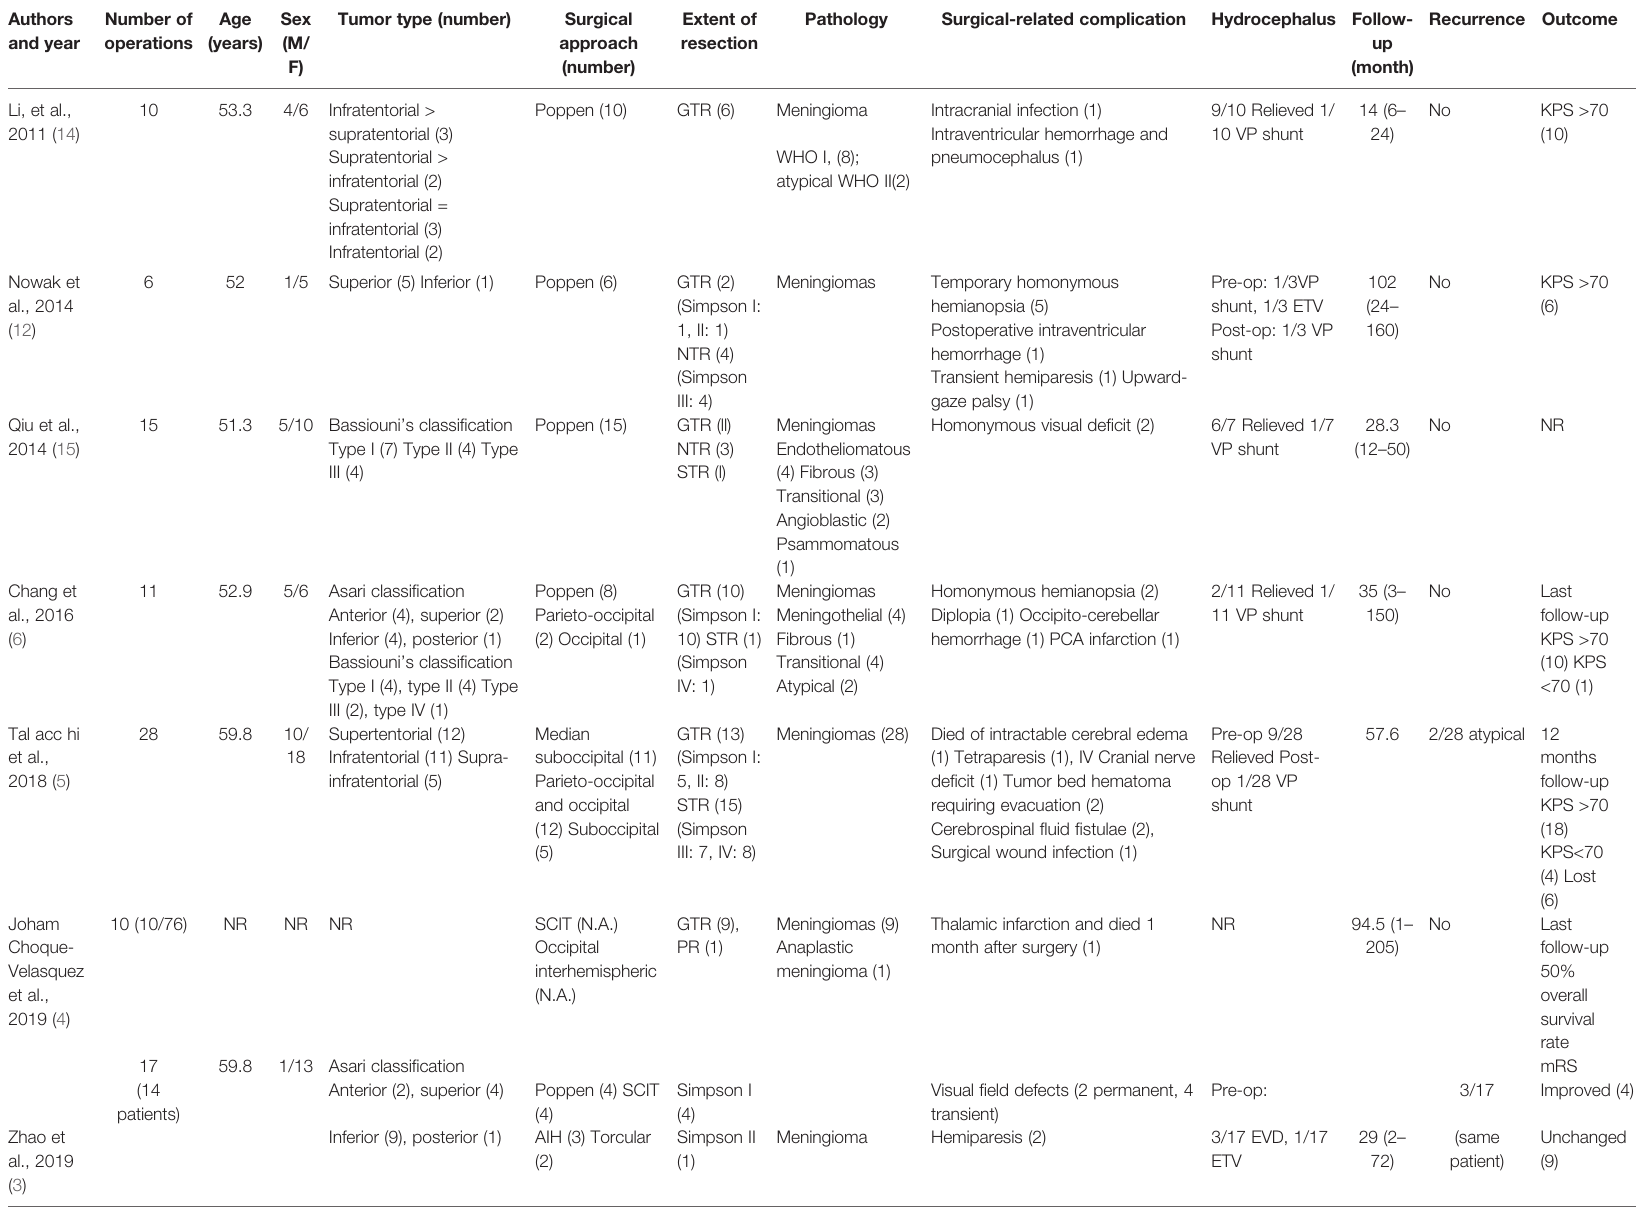
TABLE 2 | Literature review and summary of previously published studies on pineal